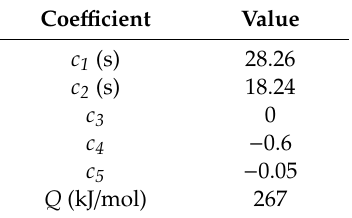
Table 4. Coe ffi cient used in Equation (9) for predicting the ferrite grain size after SRX [27].